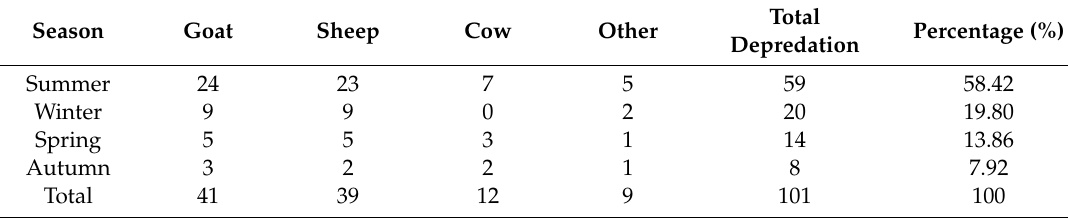
Table 2. Rate of Grey Wolf Depredation in Di ff erent